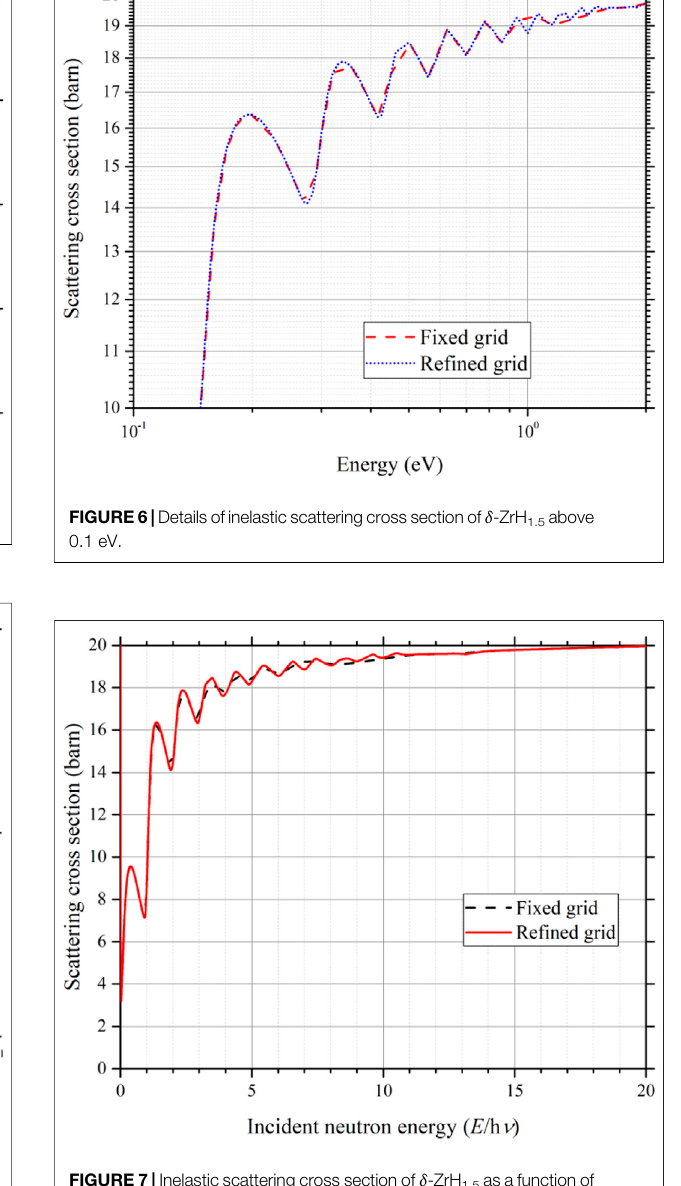
FIGURE 7 | Inelastic scattering cross section of δ -ZrH 1.5 as a function of numbers of hv